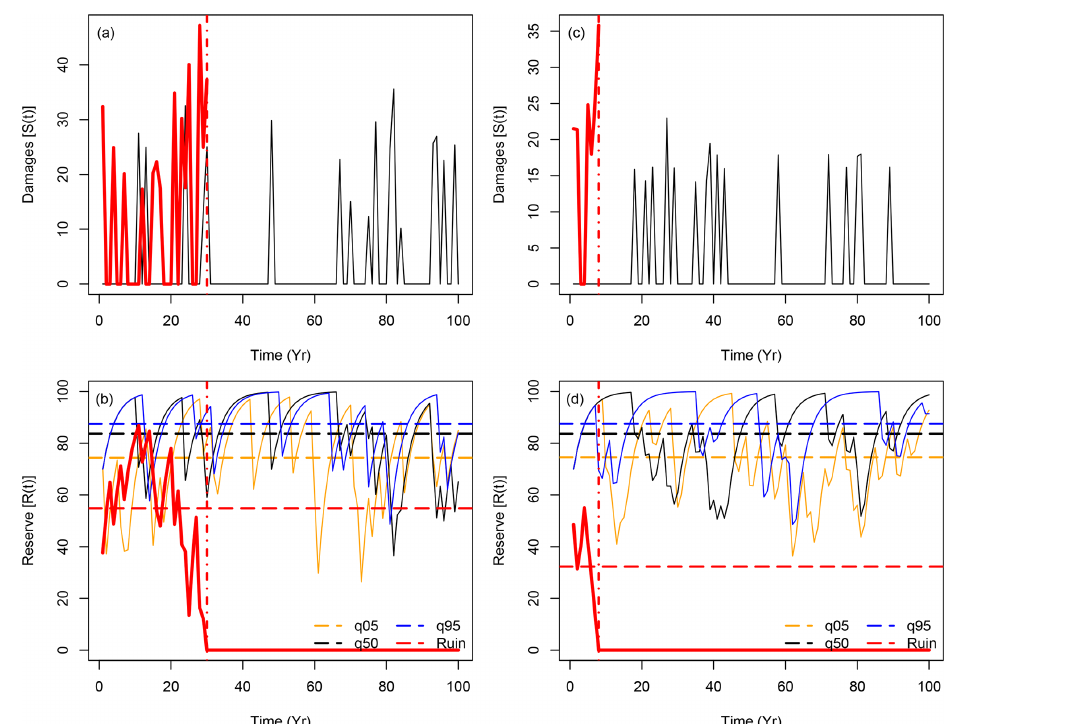
Figure 1. Sample of time series for simulations of S ( t ) (upper panels) and R ( t ) (lower panels) with B = 0 (isohydric: panels a and b ) and B = 0 . 4 (anisohydric: panels c and d ). The red lines show sample trajectories of S ( t ) and R ( t ) for which R ( t ) reaches 0 in t < 100 years. A vertical dashed-dotted line indicates the ruin time. The black lines indicate trajectories of S ( t ) and R ( t ) (for B = 0 and B = 0 . 4) that achieve the median of the temporal mean of all 10 4 trajectories of R ( t ). The orange and blue lines in panels (b) and (c) show the trajectories of R ( t ) that achieve the 5th and 95th quantiles of all 10 4 simulation means. The horizontal dashed lines in the lower panels (b) and (d) represent the means of the represented trajectories before ruin.